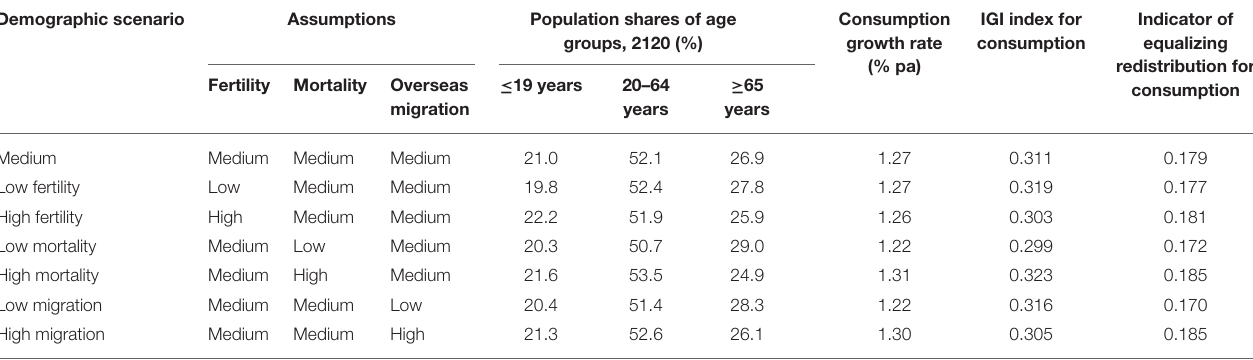
TABLE 1 | Population shares of different age groups, age-specific, per capita consumption growth rates, the IGI index for consumption, and the indicator of equalizing redistribution for consumption under different demographic scenarios, 2020–2120,